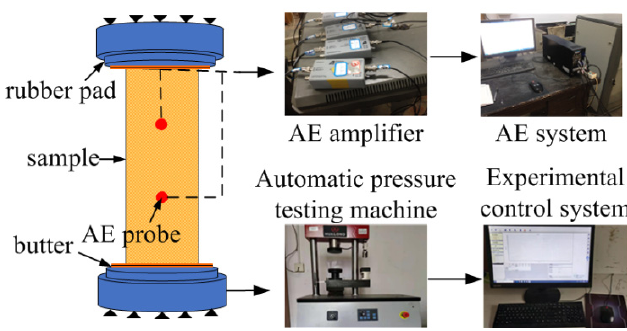
Figure 2. Schematic diagram of the experimental facility.